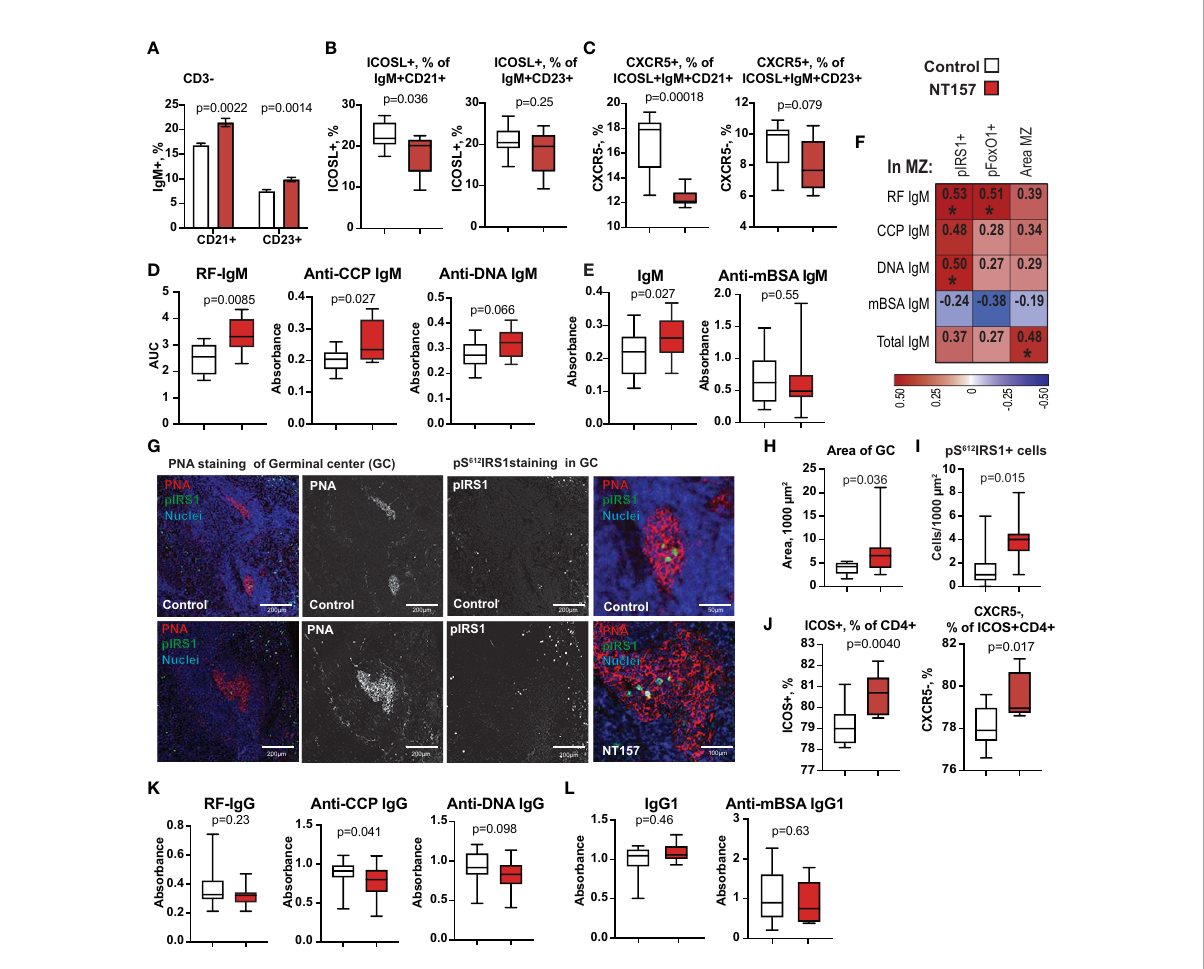
FIGURE 3 Changes in IgM + CD19 + B cells and function after inhibition of IGF1R signalling. (A) Bar plots of changes in CD21 and CD23 expression on IgM + CD19 + cells. (B) Box plots of frequency of ICOSL on CD21 + and CD23 + B cells. (C) Box plots of frequency of CXCR5 on ICOSL + CD21 + and ICOSL + CD23 + IgM + CD19 + cells. (D) Box plots of IgM antibodies against RF, CCP, dsDNA. (E) Box plots of total IgM and anti-mBSA IgM antibodies. (F) Correlation heatmap between MZ area, density of pIRS1 + and pFOXO1 + cells in MZ and autoantibody production. Spearman corelation was applied. (G) Confocal images of PNA staining of GC and perifollicular. pIRS staining in GC of NT157-treated and control mice. (H) Area of PNA + GC. (I) Density of pIRS + cells. (J) ICOS + CD4 + and CXCR5 + ICOS + cells. (K) Box plots of IgG antibodies against RF, CCP, dsDNA. (L) Box plots of total IgG and anti-mBSA IgG antibodies in serum of NT157/shIGF1R-treated and control mice.